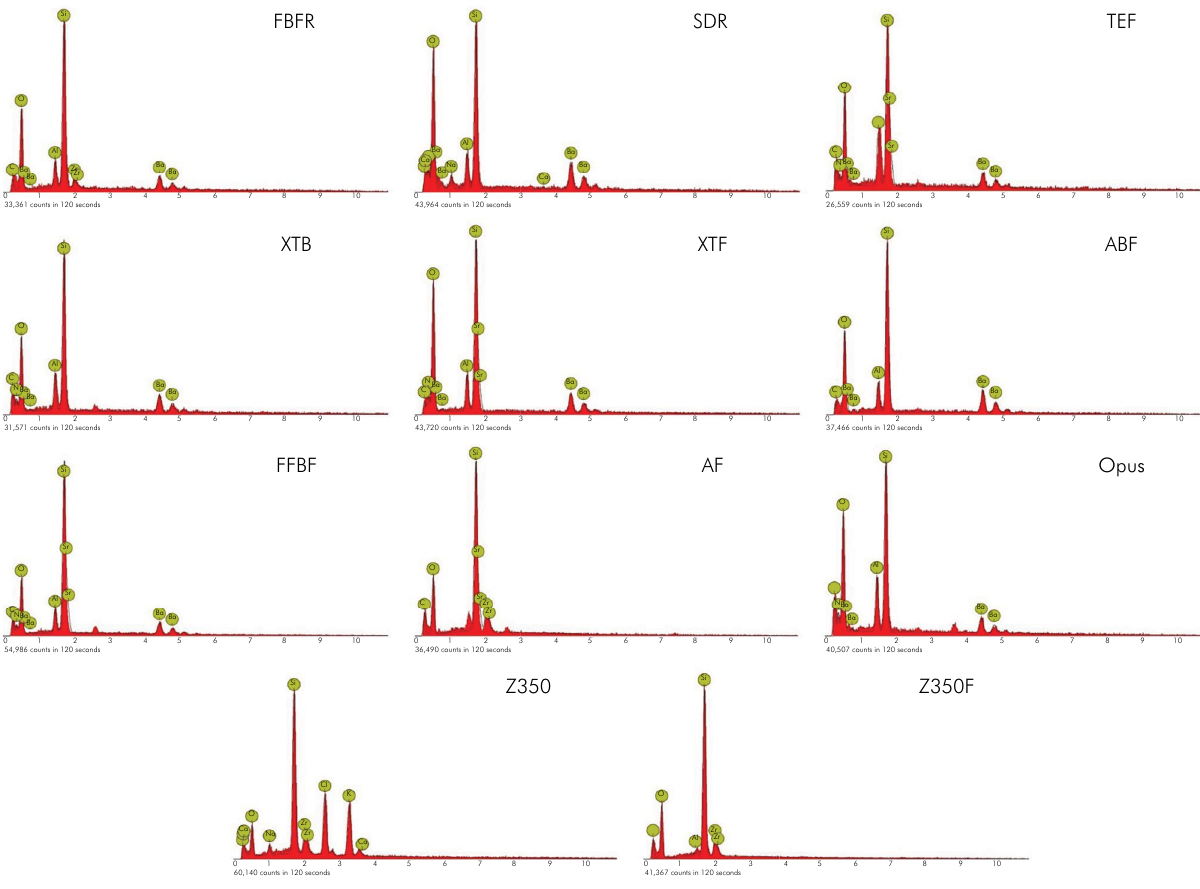
Figure 1. Representative EDS images of bulk-fill dental composites. Chemical elements present in each sample, obtained by EDS analysis.